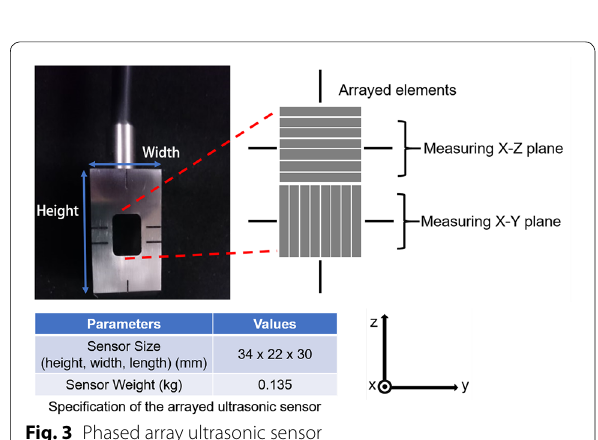
Fig. 3 Phased array ultrasonic sensor